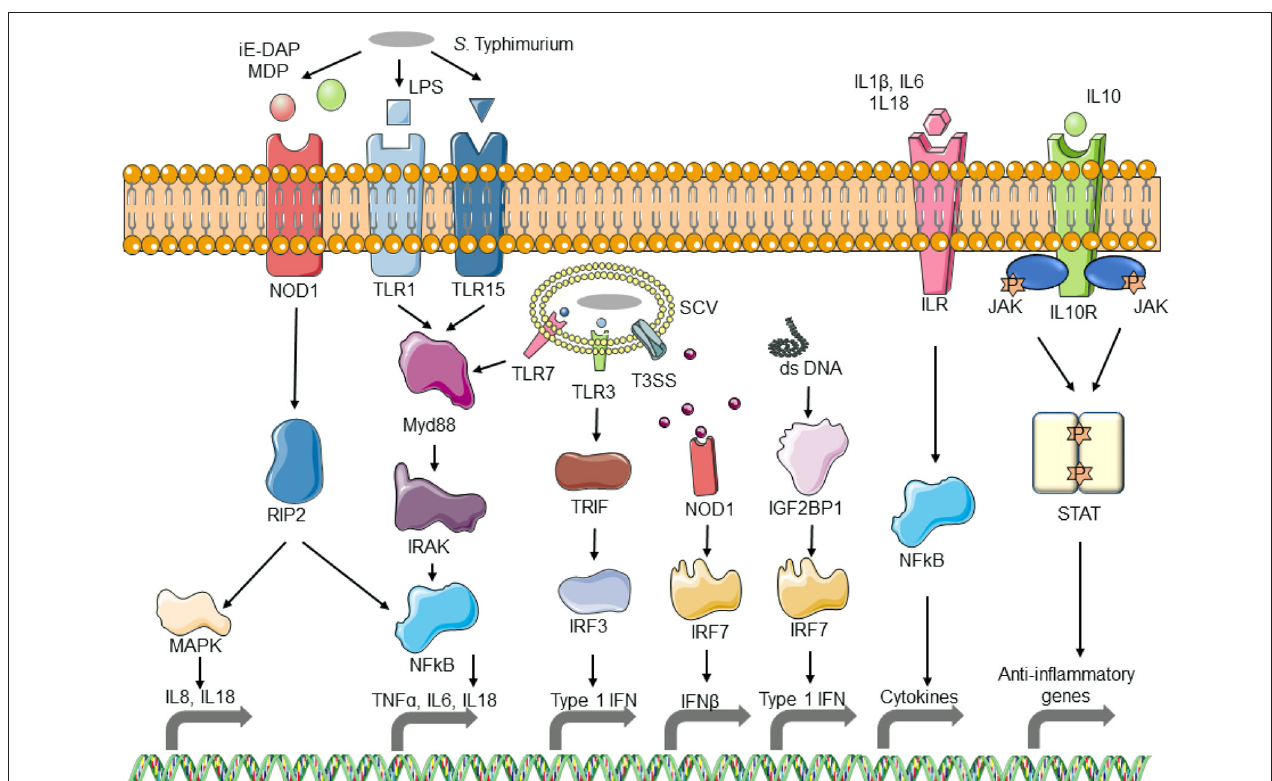
FIGURE 8 | Schematic diagram of the response of macrophages to Salmonella infection. As S. Typhimurium comes in contact with macrophages, the pathogen-associated molecular patterns (PAMPs) are recognized by Toll-like receptors (TLRs) which activate the TLR pathway, resulting in the activation of interleukins and inflammatory cytokines. PAMPs from phagocytosed bacterial also activate TLR and Nod-like receptor (NLR) pathways. Bacterial DNA released into the macrophage cytosol is recognized by the cytosolic DNA sensing pathway and results in the activation of interferon. The resulting interleukins get recognized by interleukin receptors and initiate the expression of inflammatory